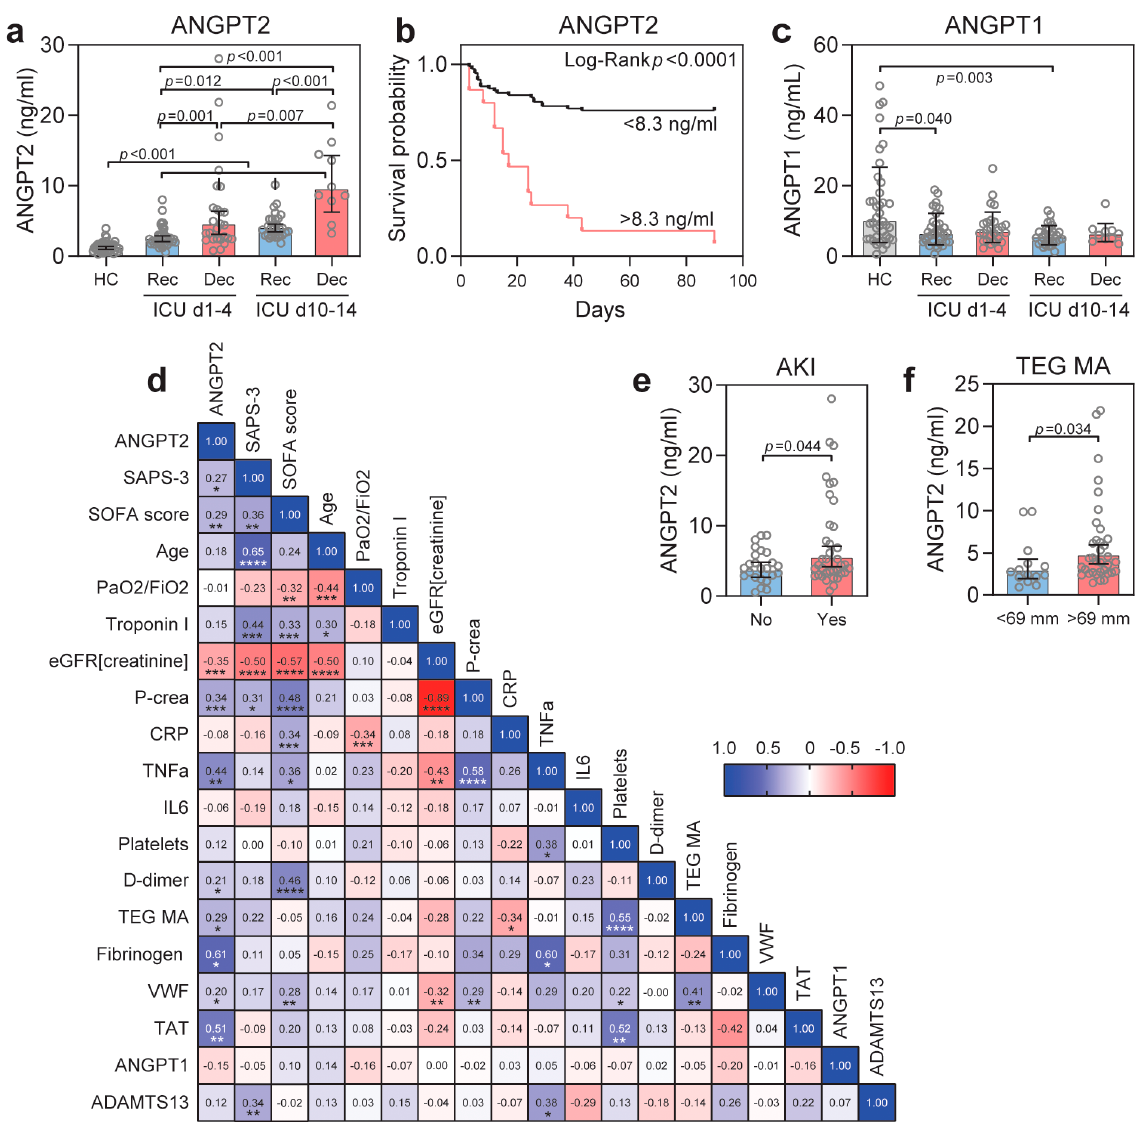
Figure 5. ( a ) Plasma ANGPT2 concentrations for healthy controls (HC), recovered (Rec), and deceased (Dec) patients at day 1–4 and day 10–14 after admission; ( b ) Kaplan–Meier survival plot with Log- rank test show that ANGPT2 levels can predict survival; ( c ) Plasma ANGPT1 was minimally affected; ( d ) Clinical data and measured parameters were analyzed by Pearson correlation test (Spearman for SAPS-3 and SOFA score) and presented in a heatmap for correlation (blue) or inverse correlation (red), * p < 0.05, ** p < 0.01, *** p < 0.001, **** p < 0.0001; ( e ) ANGPT2 is higher in patients with acute kidney injury (AKI) compared to non-AKI patients; ( f ) ANGPT2 is higher in patients with TEG MA > 69 mm. Data are presented as mean ± 95% CI. Statistical comparison from one-way ANOVA with Bonferroni post hoc test ( a , b ) or Student’s t -test ( e , f ). AKI, acute kidney injury; TEG, thromboelastography; MA, maximal